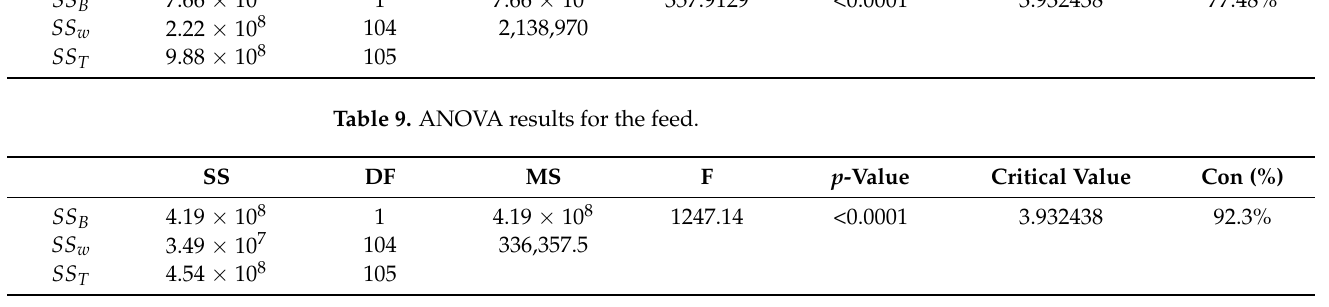
Table 10. ANOVA results for the milling